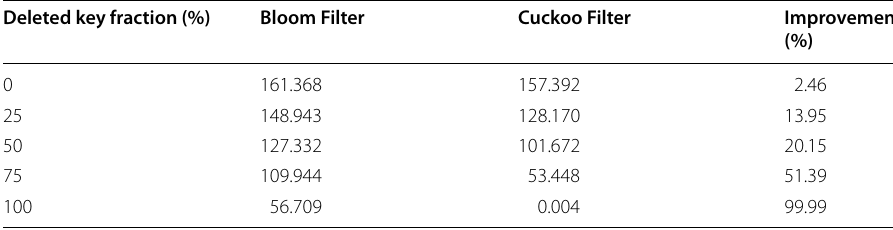
Table 2 Experimental results 1: Lookup performance after deletion for varying queries retrieving deleted rows. Query execution time in seconds. (Each query results in 5M rows)